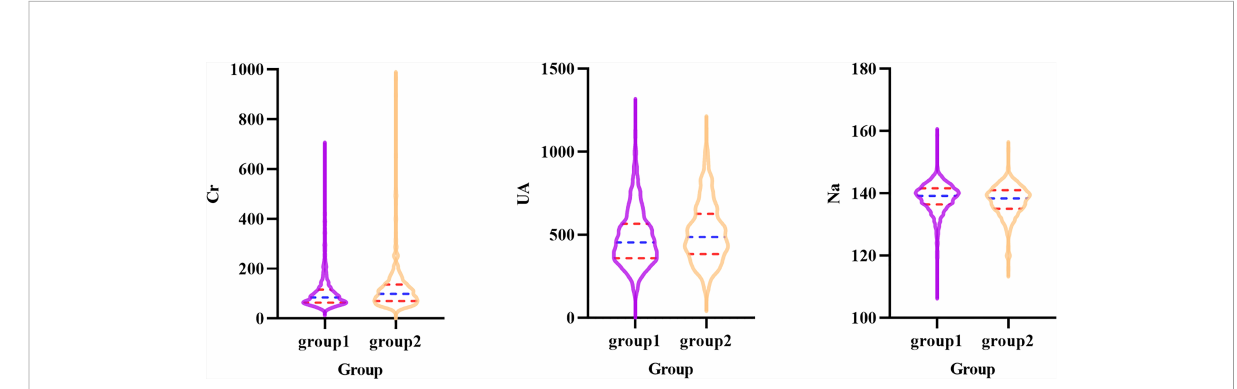
FIGURE 6 Violin plot of Cr, UA and Na in patients with heart failure in readmission and non-readmission within 3 months groups (Group1: non- readmission; Group2: